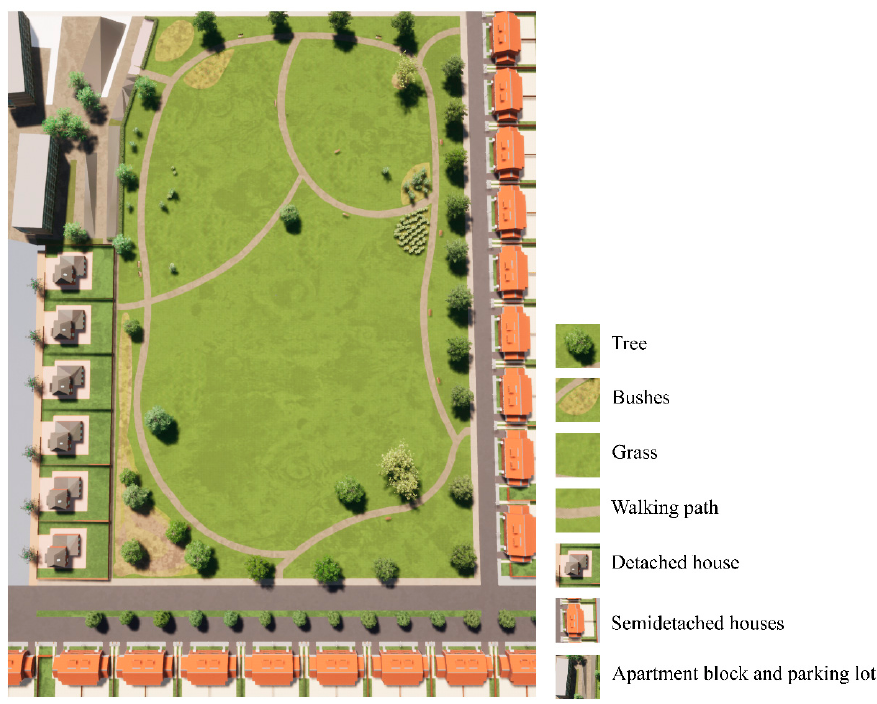
Figure 1. Top view of the baseline park.